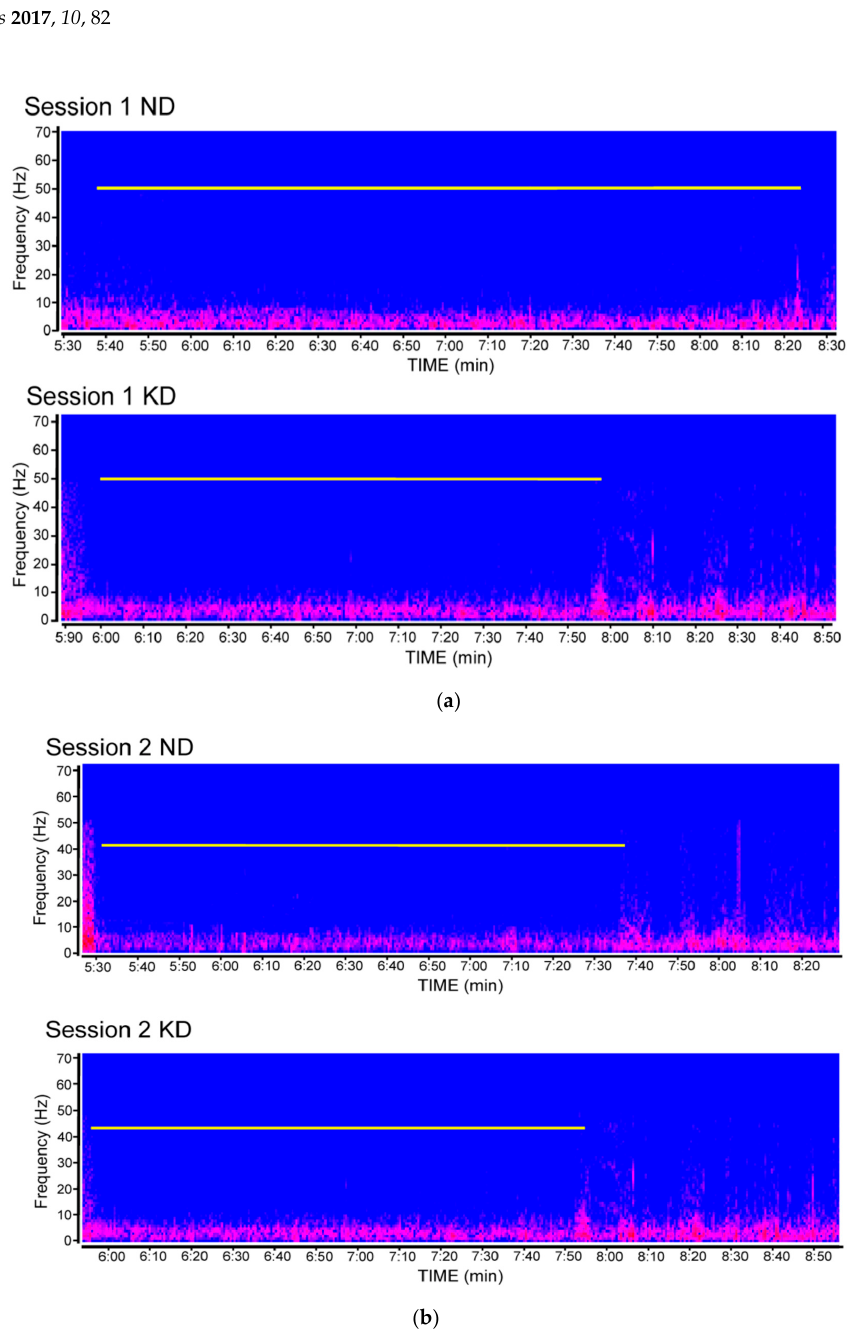
Figure 3. Compressed spectral array showing the duration of post-ictal depression in video electrocorticographic (ECoG) recordings obtained from mice fed the ketogenic diet (KD) or a normal diet (ND) and repeatedly tested in the 6-Hz corneal stimulation model. ( a ) EcoG traces illustrating the response detected in the first session of seizure induction. The white line indicates the duration of post-ictal depression. In ( b ), EcoG traces from mice stimulated in the second session of seizure induction. Spectral arrays were from different mice of each respective experimental group. Note that the difference observed in the first session is no longer detectable in the second session of 6-Hz corneal stimulation.